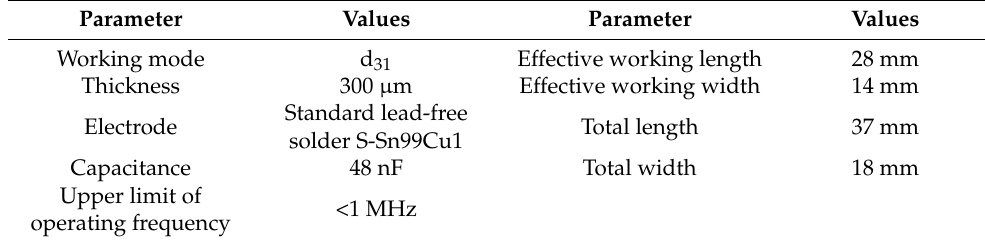
Table 2. Parameter information of MFC piezoelectric